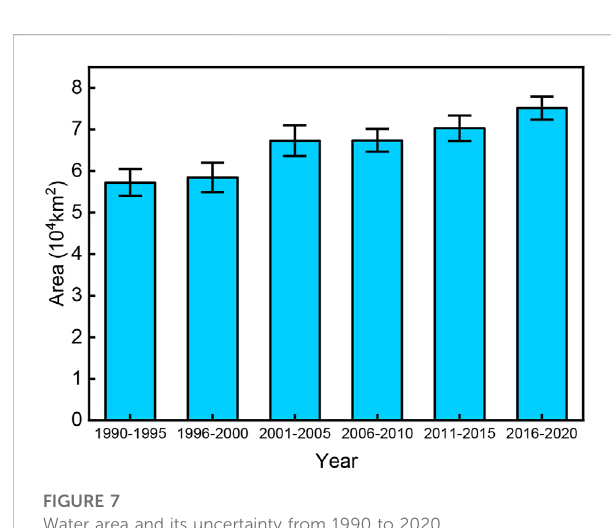
FIGURE 7 Water area and its uncertainty from 1990 to